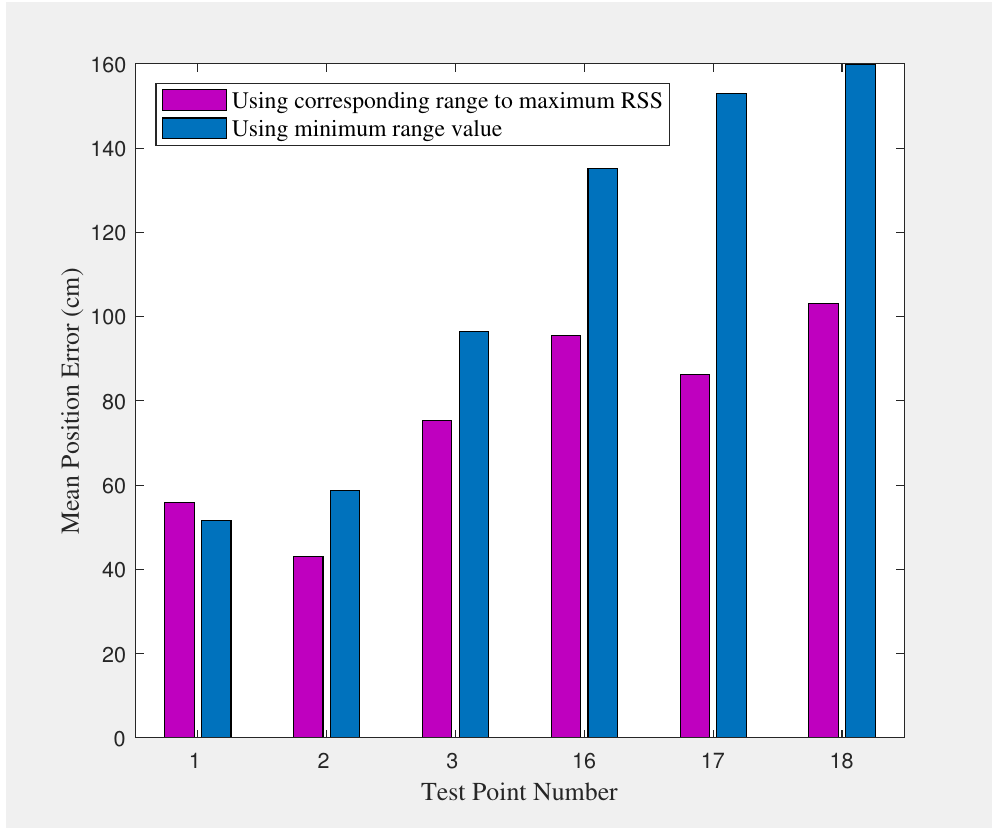
Figure 22. Position error at three Line Of Sight (LOS) and three Non-Line Of Sight (NLOS) points using several range selection